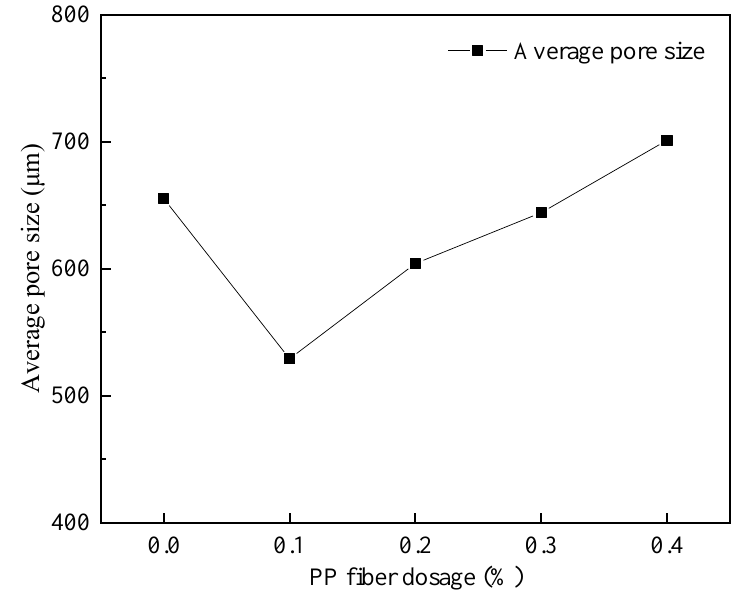
Figure 21. Effect of fiber doping on porosity.